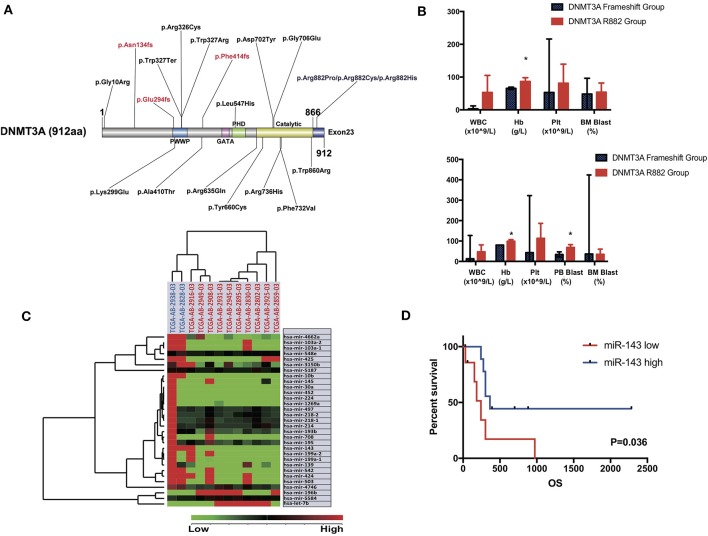
(A) Schematic drawing of the DNMT3A protein structure and the detailed position distribution of each variant that was detected. Each conserved domain is labeled with different colors, and three DNMT3A frameshift mutations are marked with red letters. (B) Bar chart of mean value and standard deviation of the clinical characteristics (WBC, hemoglobin, platelet level of peripheral blood and blast percentage in bone marrow and peripheral blood sample) of AML patients carrying DNMT3A R882 and DNMT3A frameshift mutations from the patient cohort in our center (upper chart) and TCGA cohort (lower chart). Significant differences between the two groups were compared by an unpaired t-test (*P < 0.05). (C) Unsupervised hierarchical clustering analysis was performed on the significantly differentially expressed microRNAs in AML cases with DNMT3A R882 and DNMT3A frameshift mutations from the TCGA database. The cluster diagram of the miRNA expression values was mean-normalized. Samples with the DNMT3A R882 mutation are labeled with a red ID marker, while those with DNMT3A frameshift mutations are labeled with a blue ID marker. (D) Overall survival comparison of 2 groups of AML patients carrying DNMT3A mutations (R882s and non-R882s) from the TCGA database. Patients were separated into high/low group by the expression value ranking of miR-143. Each group contained nine patients, whose expression value ranked top or bottom 45%. Survival analysis was performed with the Kaplan-Meier method and was statistically compared with the Gehan-Breslow-Wilcoxon test.